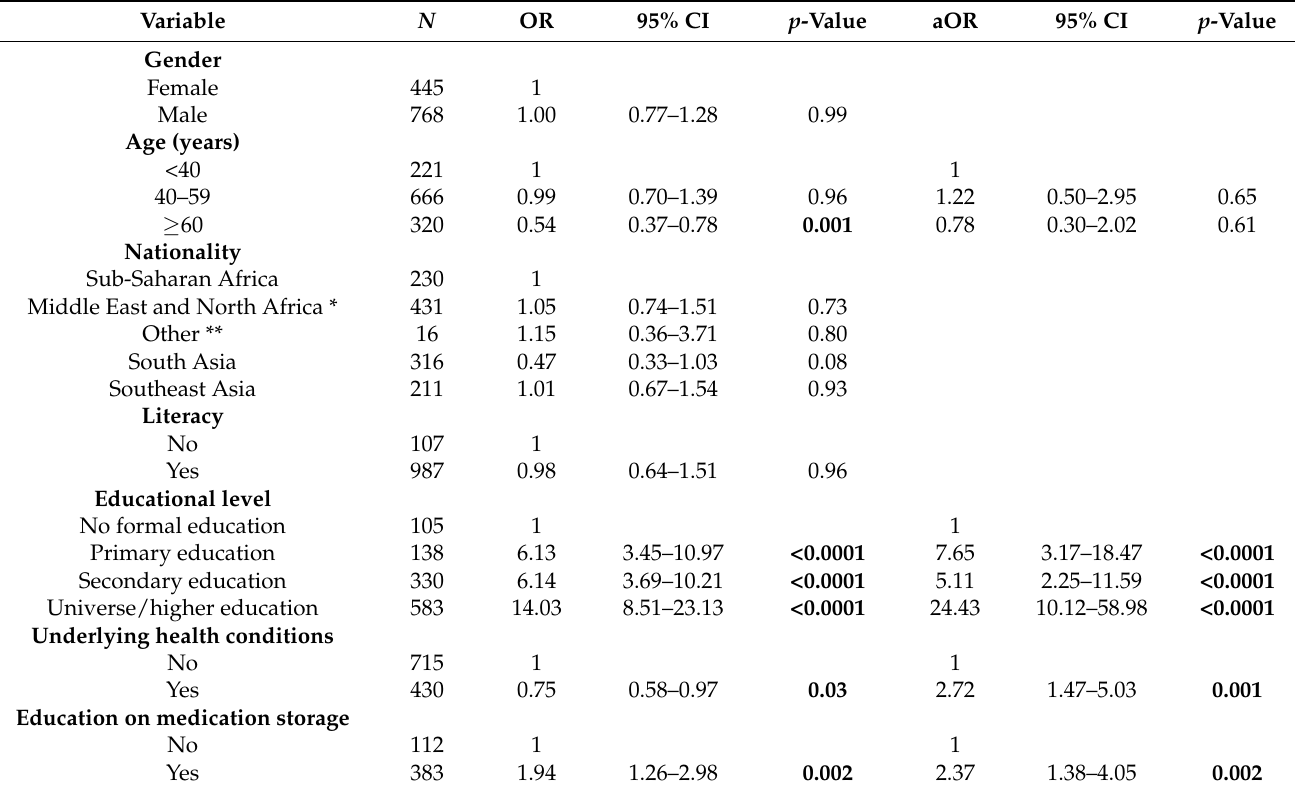
Table 2. Association between variables and good knowledge of medication storage among Hajj